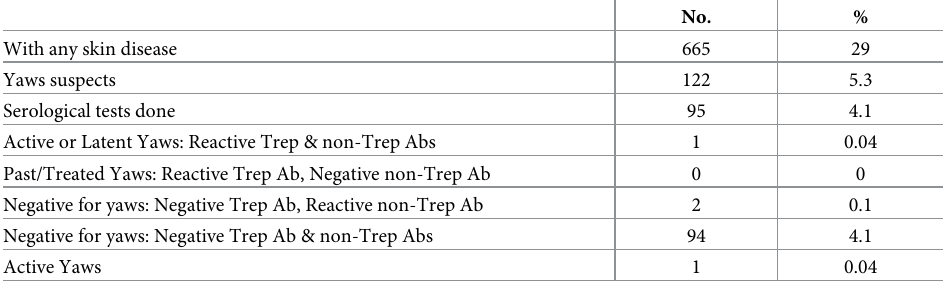
Table 2. Clinical & serological results of schoolchildren screened (N = 2291).